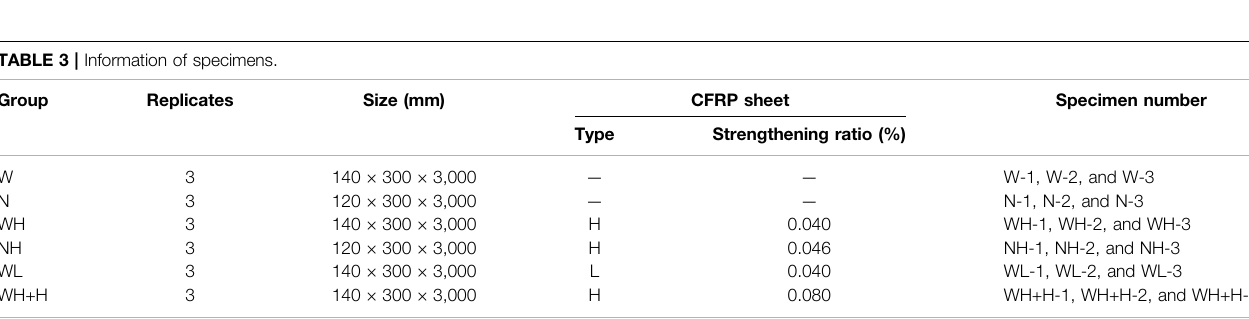
TABLE 3 | Information of